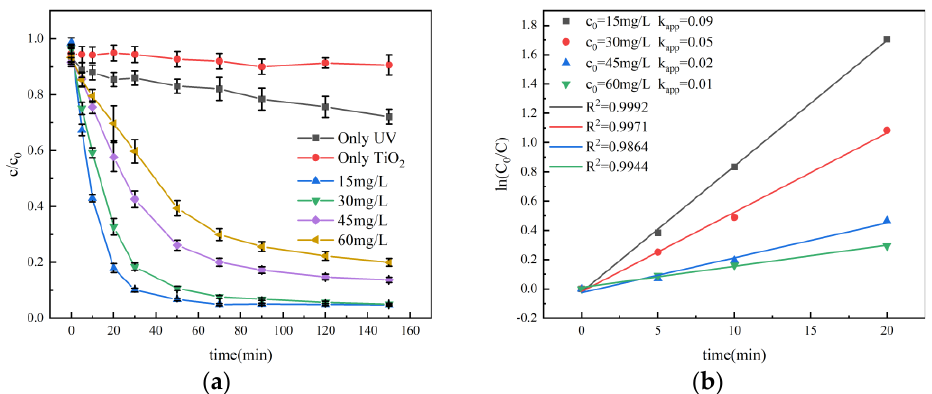
Figure 8. ( a ) Evolution of AR 26 concentration with different initial concentrations; ( b ) Kinetic fits for initial concentrations of 15, 30, 45, and 60 mg/L.